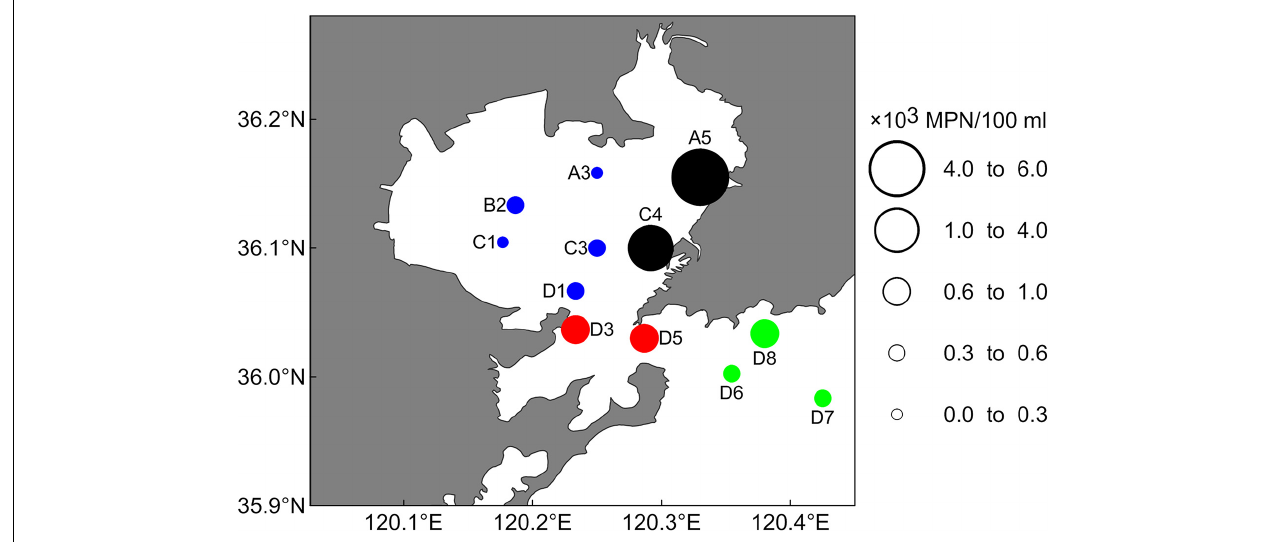
FIGURE 4 | Spatial distribution of the average abundances in 12 stations. The sizes of the colored circles indicate relative average abundances of CB. The black, blue, red, and green circles indicate sampling stations in the estuary area, the inner bay area, the bay mouth area, and the outer bay area,